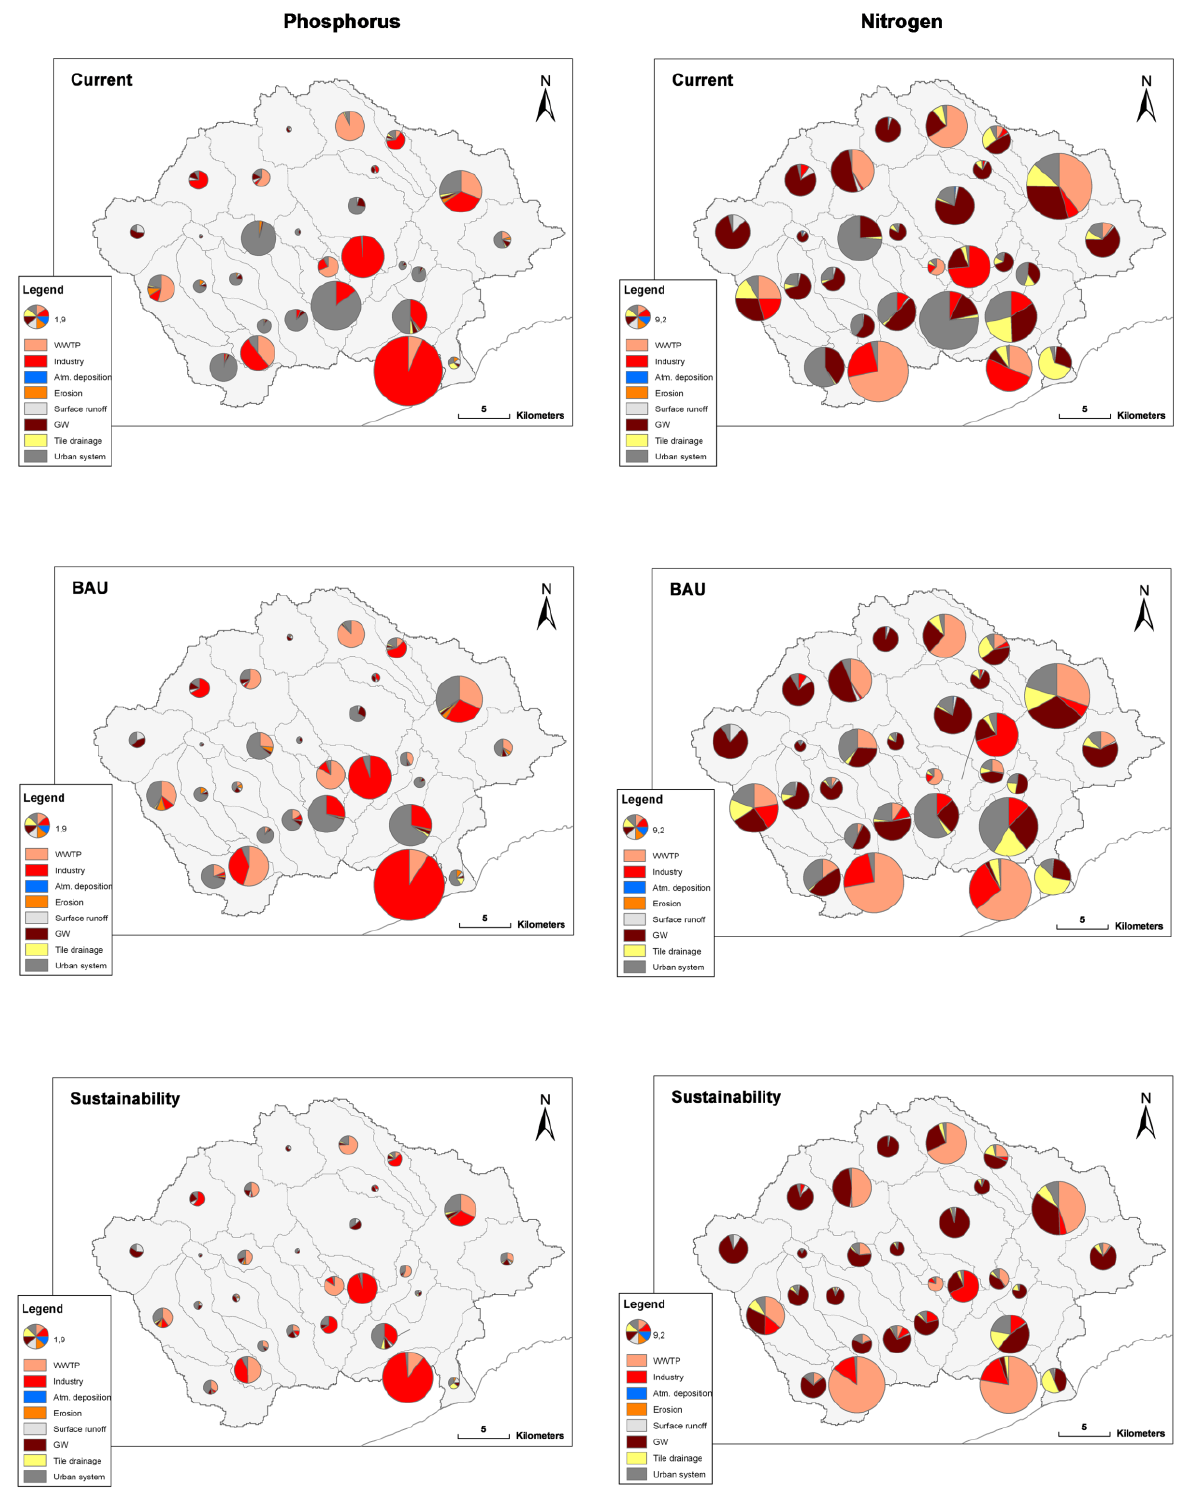
Fig. C1. Partitioning of the total emissions of P and N by emission pathway in La Tordera basin for the “BAU” and “Sustainability” scenarios compared to the “Current” scenario. Pie sizes are proportional to total emissions of P and N